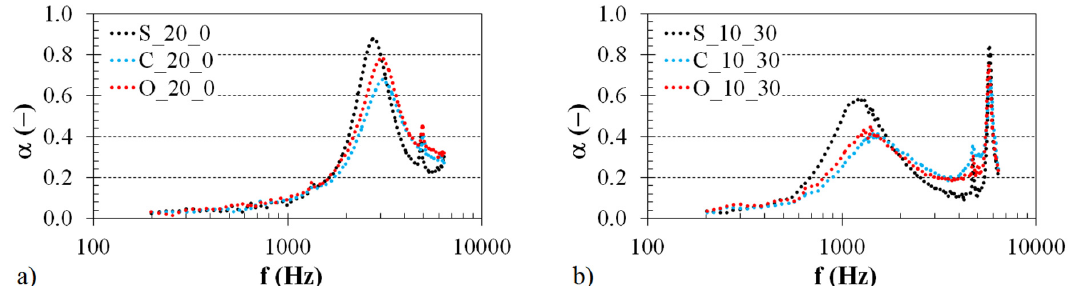
Figure 4. Effect of the 3D-printed ABS material structure on the frequency dependencies of the sound absorption coefficient; ( a ) sample thickness t = 20 mm, air gap size a = 0 mm, ( b ) sample thickness t = 10 mm, air gap size a = 30 mm.